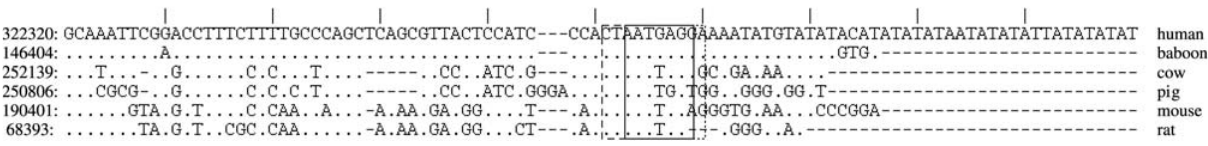
Figure 5 - A region from HoxA cluster standing in a stark contrast with its environment. Solid line box encloses the area of perfect conservation in all spe- cies. Dashed and dotted lines show the areas of rodent and primate differential conservation, respectively. Dots indicate the same letter as in row 1 (hu-